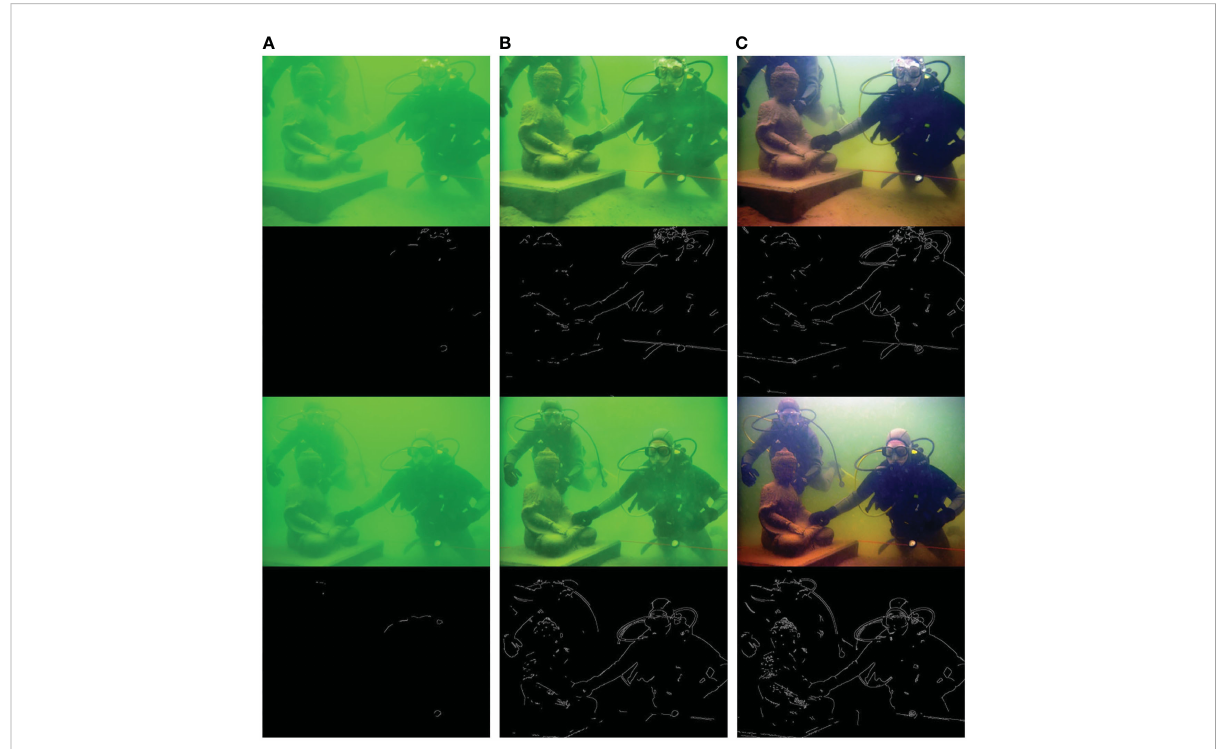
FIGURE 18 The visual results of Canny edge detection. From left to right, (A) shows the raw underwater images, and (B, C) are the results of CLAHE and the proposed model,